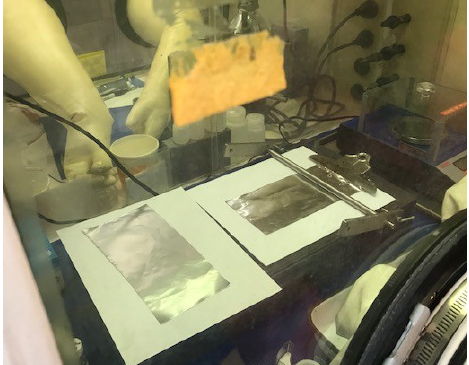
Fig 1. Draw-down machine with Mayer rod set in place on aluminum foil backing.